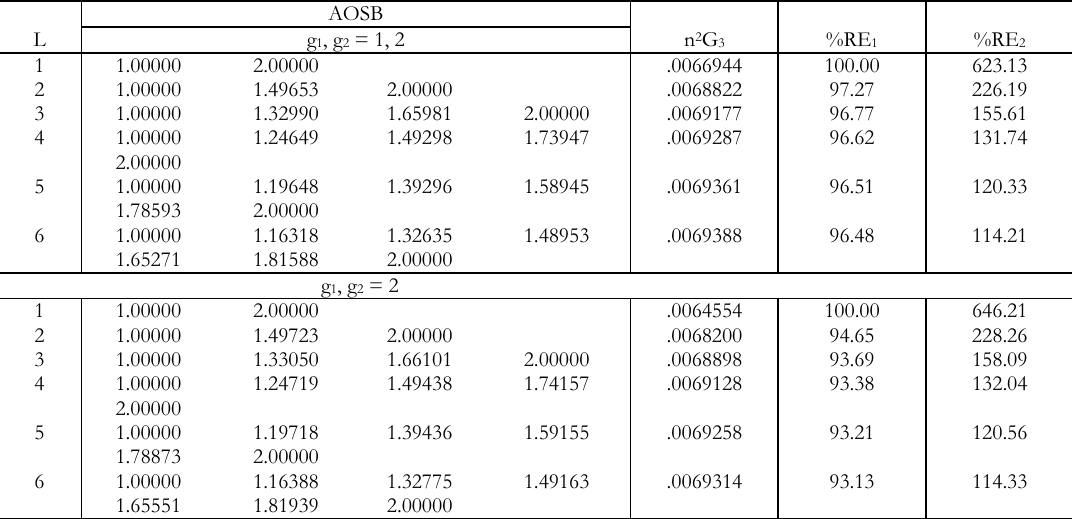
AOSB and relative efficiencies of optimum stratification (Uniform distribution) AOSB g 1 , g 2 = 1,